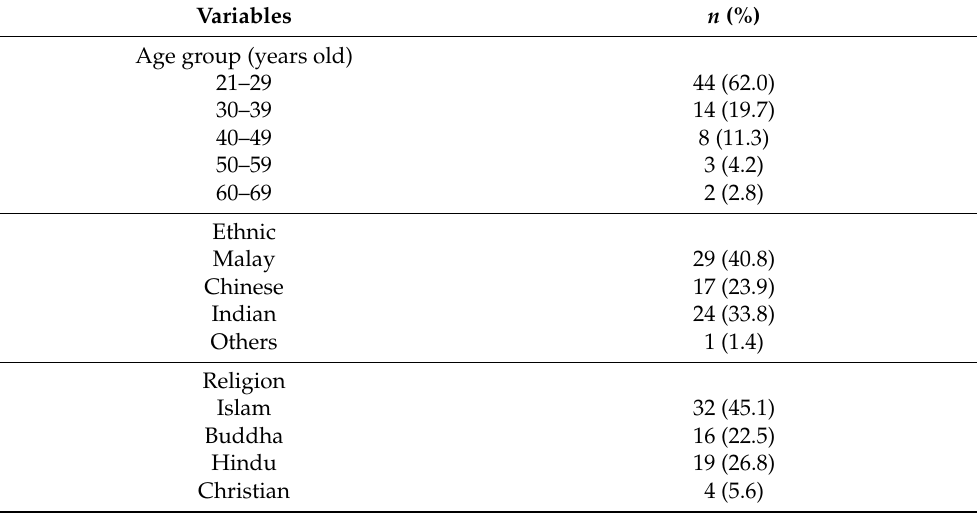
Table 1. Socio-demographic profiles of participants ( n =